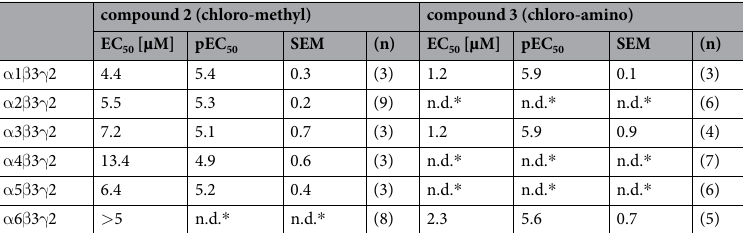
Table 1. Impact of α isoform on potency of compound 2 and 3 . EC 50 , pEC 50 and SEM of R 8 = Cl compound 2 (LAU156) and 3 (LAU206) are shown. Supplementary Tables S14 and S15 show tabulated dose-response data. Compound 2 modulates all receptors, EC 50 ranges from 4 µ M to 13 µ M, where in α 6 β 3 γ 2 the EC 50 value could not be obtained as saturation was not reached. Compound 3 has moderate modulatory effects in α 1- and α 3 β 3 γ 2 receptors with an EC 50 at ~1 µ M and in α 6 β 3 γ 2 with an EC 50 of ~2 µ M. Due to the extremely low efficacy in α 2-, α 4- and α 5 β 3 γ 2, these EC 50 values could not be obtained; (n.d. = not